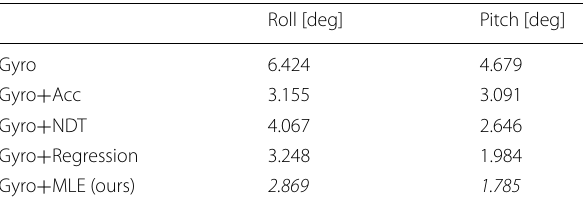
Table 12 MAE of estimated attitude during flight in unknown